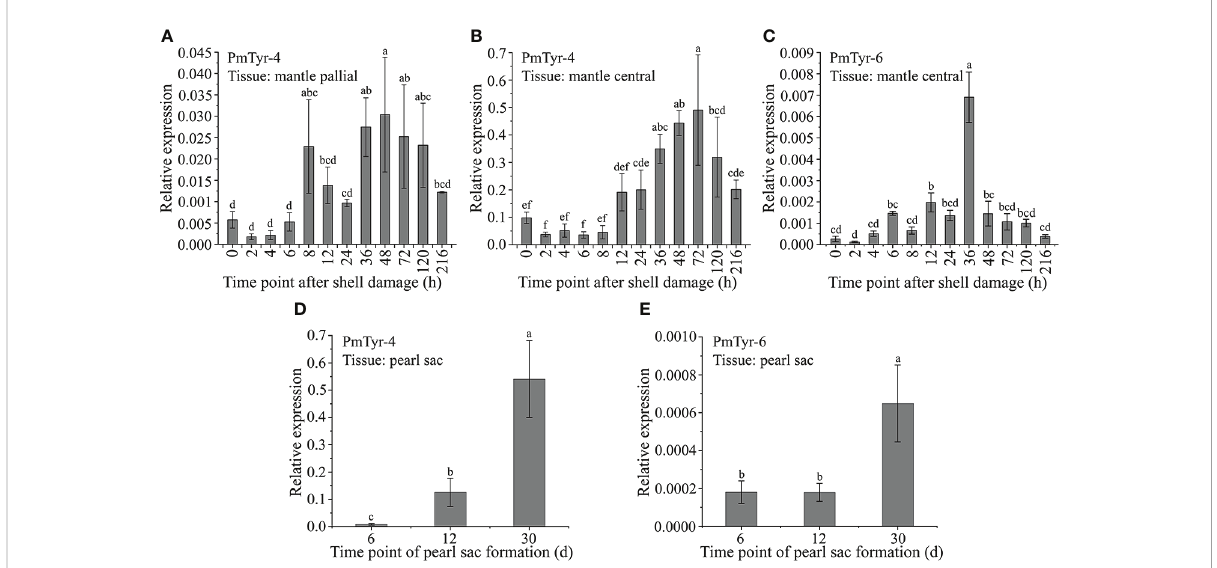
FIGURE 4 Expression patterns of PmTyr-4 and PmTyr-6 during shell regeneration and pearl formation. Statistical signi fi cance was determined by Duncan- test. Error bars correspond to mean ± SD. Different lower-case letters (A – D) are signi fi cantly different ( P<0.05 ) and same ones were not signi fi cantly different ( P>0.05 ). (A) The expression level of PmTyr-4 in mantle pallial after shell damage. (B) The expression level of PmTyr-4 in mantle central after shell damage. (C) The expression level of PmTyr-6 in mantle central after shell damage. (D) The expression level of PmTyr-4 in pearl sac after transplantation. (E) The expression level of PmTyr-6 in pearl sac after